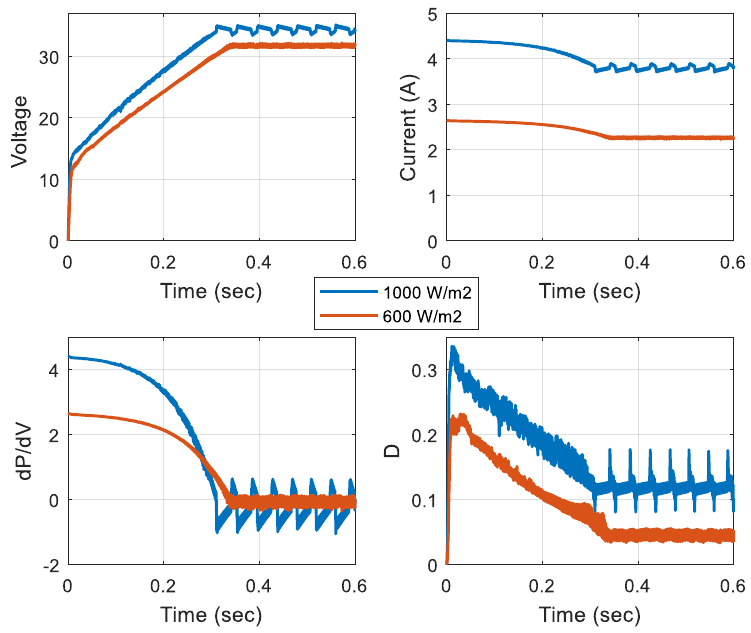
Figure 11. Voltage, current, dP / dV, and D for two irradiance cases; 1000 W / m 2 and 600 W / m 2 at 25 ◦ C Energies 2019 , 12 , x FOR PEER REVIEW Figure 11. Voltage, current, dP/dV, and D for two irradiance cases; 1000 W/m 2 and 600 W/m 2 at 25 𝐶 ° and R = 15 Ω . and R = 15 Ω.